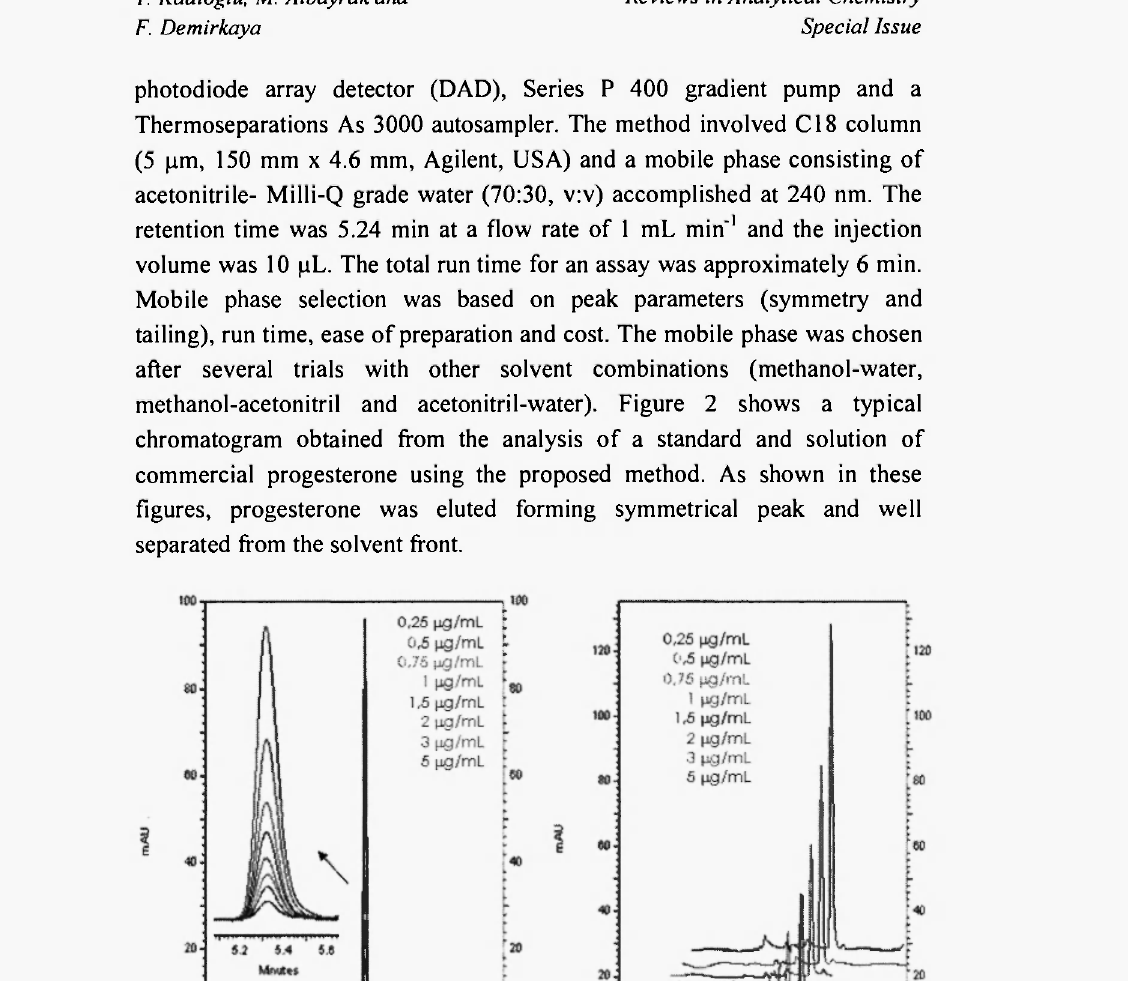
Fig. 2: Chromatograms obtained from calibration graph of a standard solution and a solution of commercial